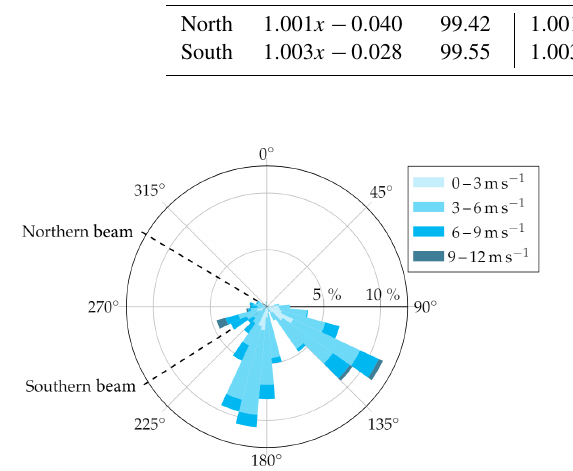
Figure 5. Wind rose derived from 10min averages of sonic anemometer wind speed and direction of the 2-month-long experi- ment. The beam directions are indicated as dashed